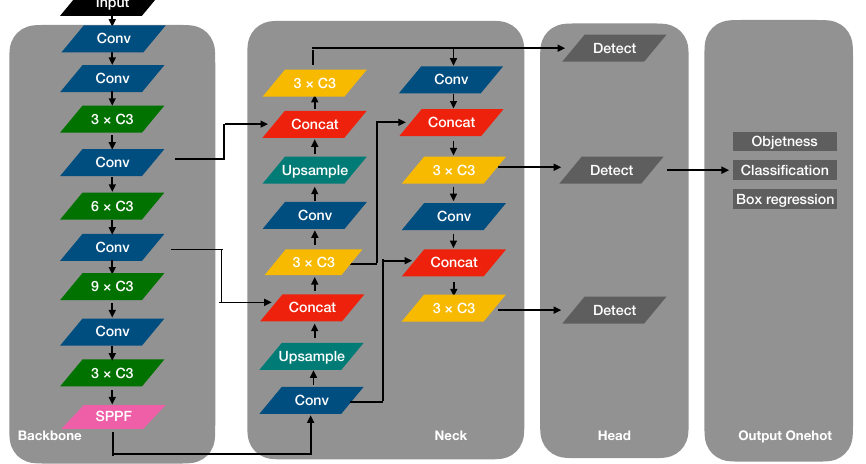
Figure 1. The network structure of YOLOv5 deep learning framework. It is mainly composed by a backbone network, neck network. and head